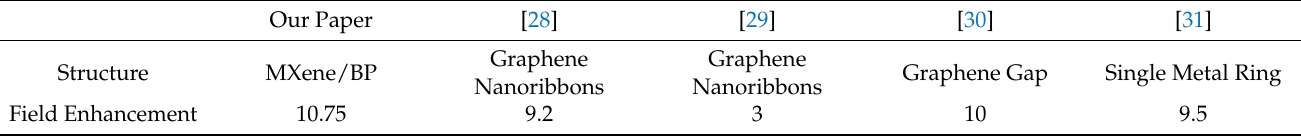
Table 1. The comparison for field enhancement between our paper and other related